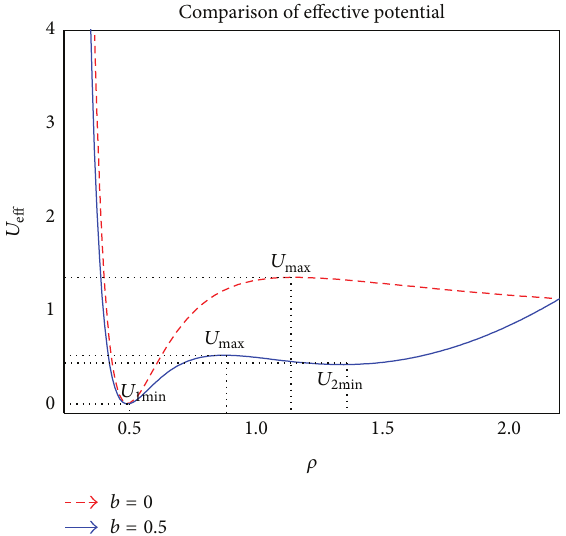
Figure 3: Effective potentials (with magnetic field, and, in its absence, a comparison) versus 𝜌 .